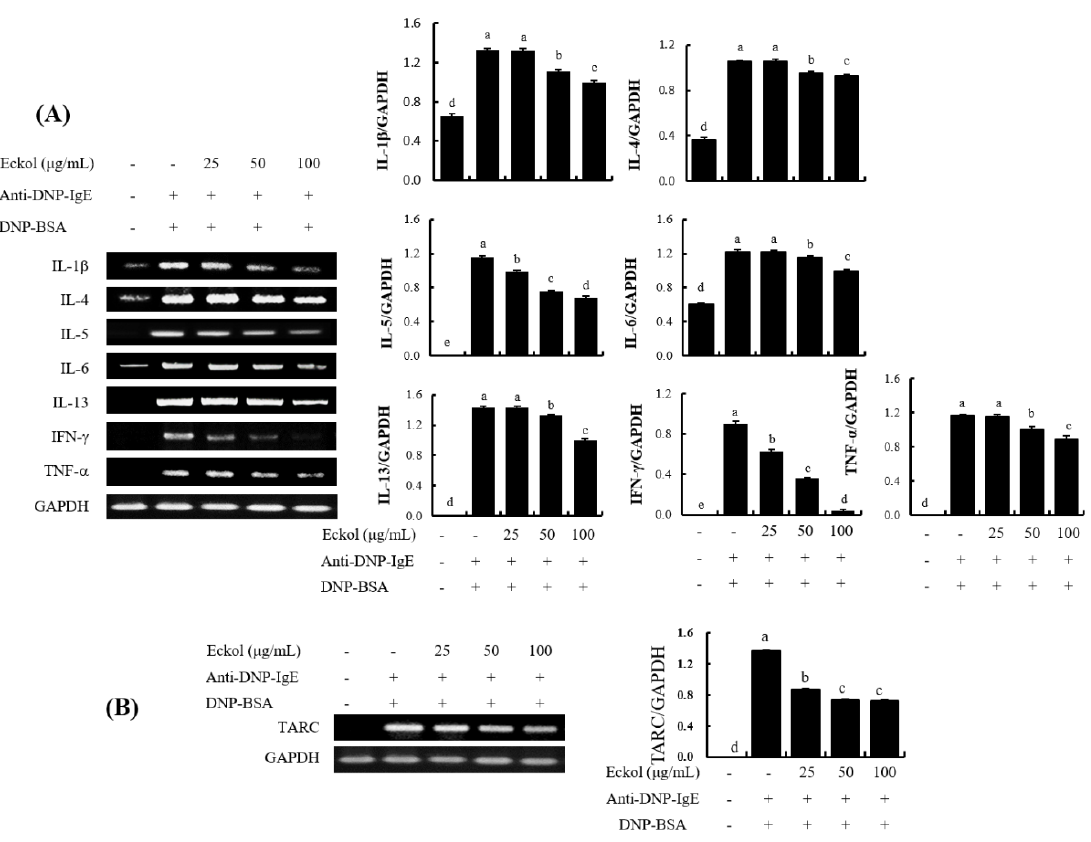
Figure 4. Effect of eckol on the gene expression of cytokines and chemokine in IgE/BSA-stimulated BMCMC. ( A ) mRNA expression of the cytokines and ( B ) the chemokine. Data are expressed as means ± SD ( n = 3) of three individual experiments. Differences in mean values among group were assessed by one-way analysis of variance followed by Duncan’s test using PASW statistics 21.0. A value of p < 0.05 was considered statistically significant.